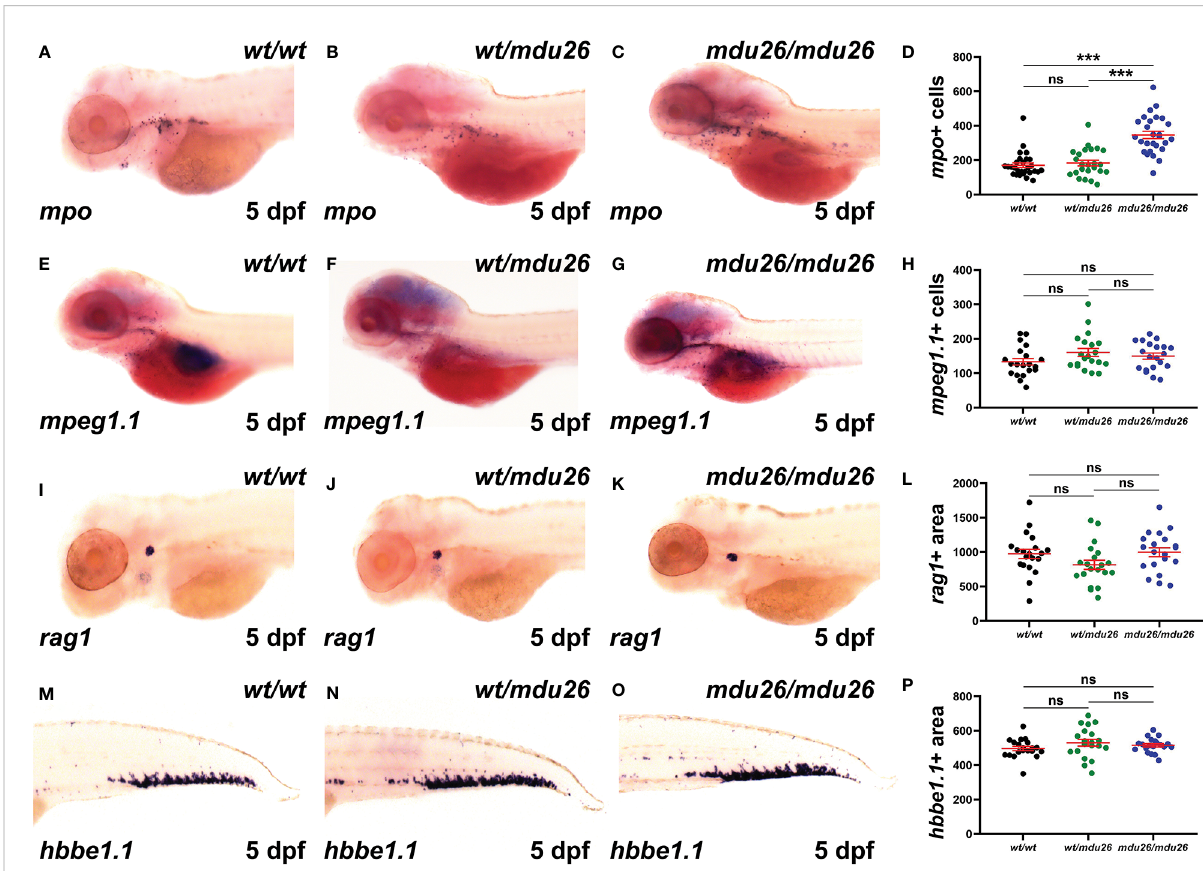
FIGURE 3 Effect of G-CSFR truncation mutation on de fi nitive hematopoiesis. Wild-type ( wt/wt ), heterozygous ( wt/mdu26 ) and homozygous ( mdu26/mdu26 ) mutant csf3r embryos were subjected to WISH at 5 dpf with mpo (A – C) , mpeg1.1 (E – G) , rag1 (I – K) and hbbe1.1 (M – O) , with representative images shown. Individual embryos were assessed for the number of mpo + (D) or mpeg1.1 + (H) cells or the area of staining for rag1 (L) or hbbe1.1 (P) , with mean and SEM shown in red and level of statistical signi fi cance indicated (***: p < 0.001, ns: not signi fi cant;